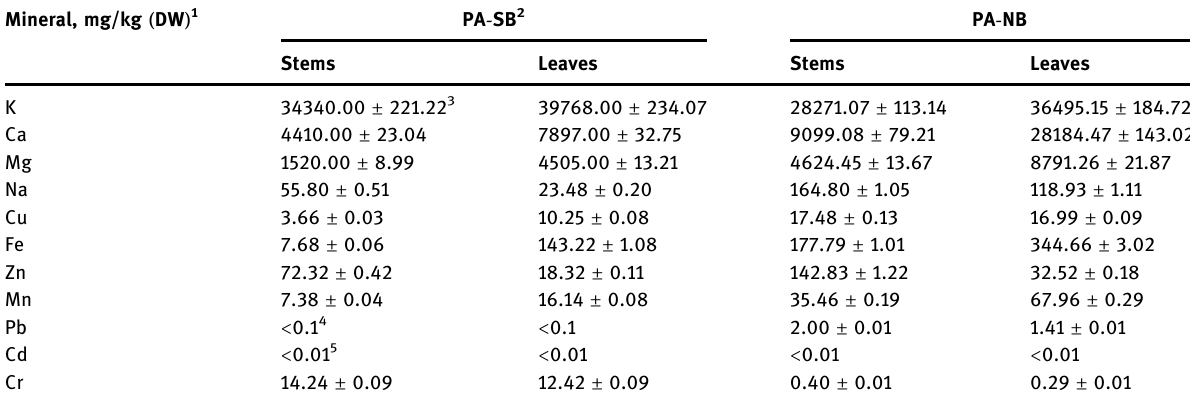
Table 3: Mineral composition of P. alkekengi leaves and stems Mineral, mg/kg ( DW ) 1